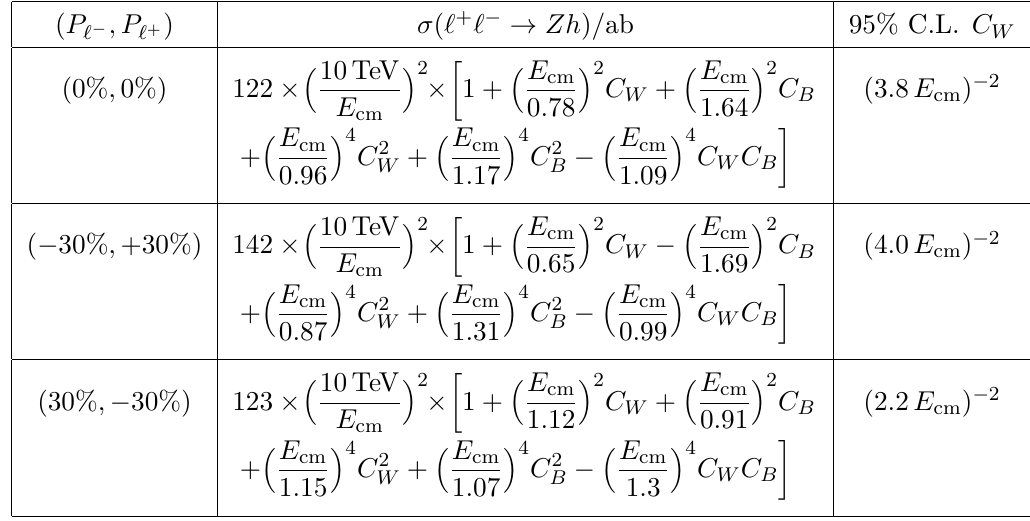
Table 2 . Total ‘ + ‘ − → Zh cross-section in ab, as a function of the collider energy E cm and the Wilson coefficients C W , C B , for different beam polarizations (polarization − 100% means fully left- handed (right-handed) particles (antiparticles)). The 95% C.L. symmetrized individual